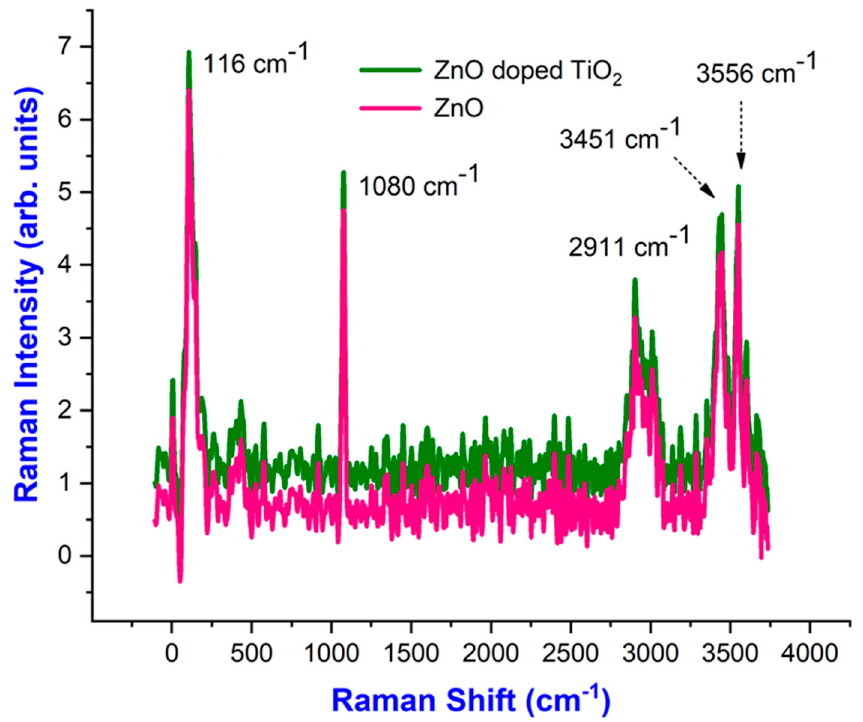
Figure 6. Raman spectrum of synthesized pure ZnO and ZnO doped TiO 2 nanocomposites.